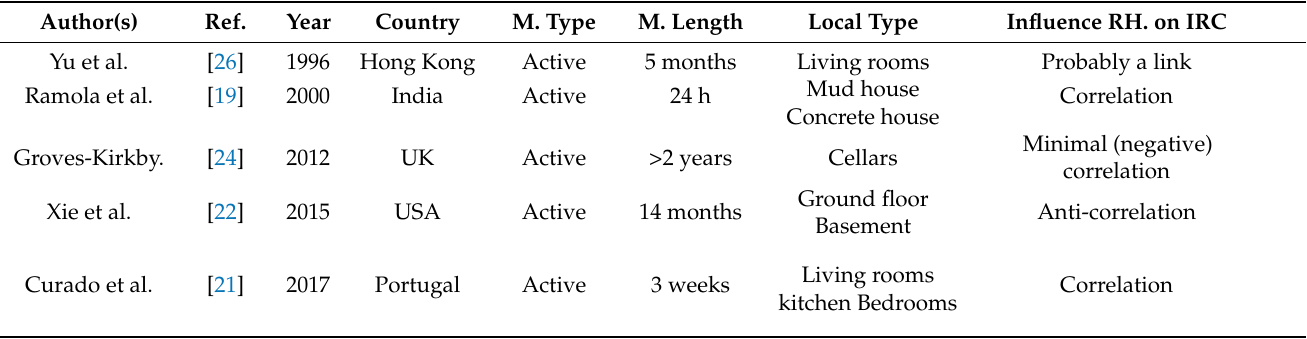
Table 4. Synthesis of outdoor relative humidity influences on IRC highlighted in a selected literature. (Ref.: references; M.: measurements; RH: relative humidity).